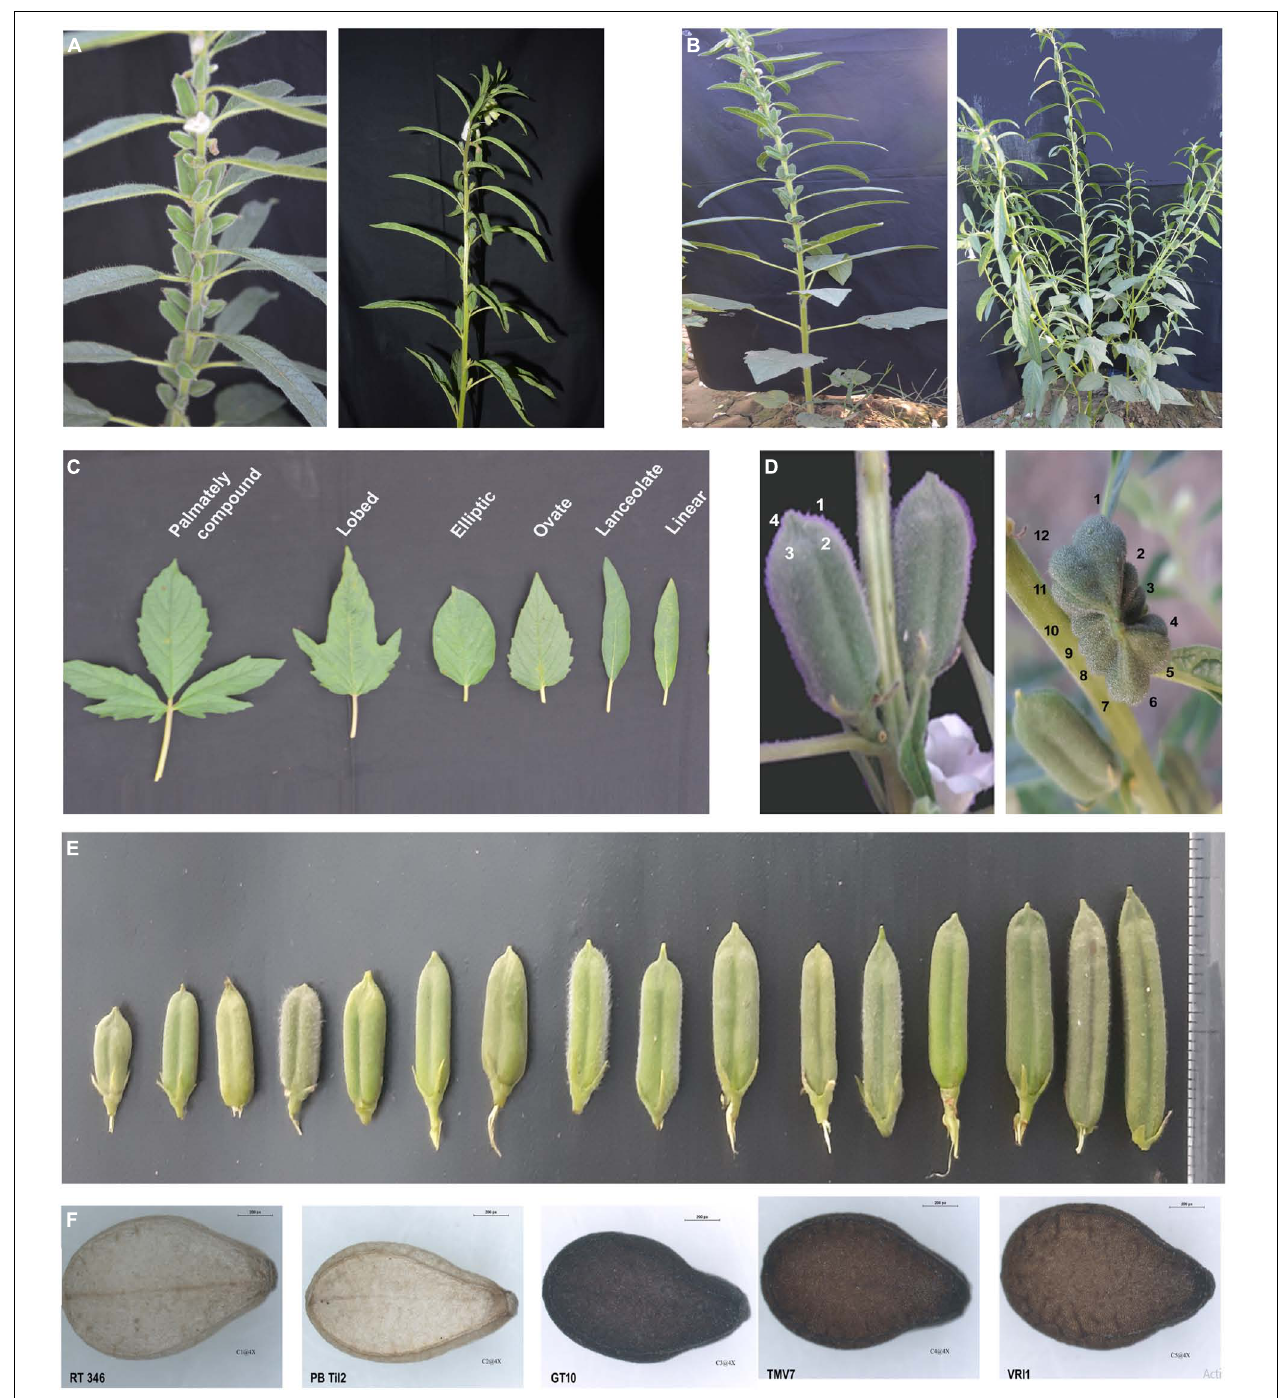
FIGURE 3 | Variability in sesame germplasm for agro-morphological traits. (A) Internode stem length, (B) branching pattern, (C) leaf shape, (D) locules per sesame capsule, (E) capsule length, and (F) seed coat color.